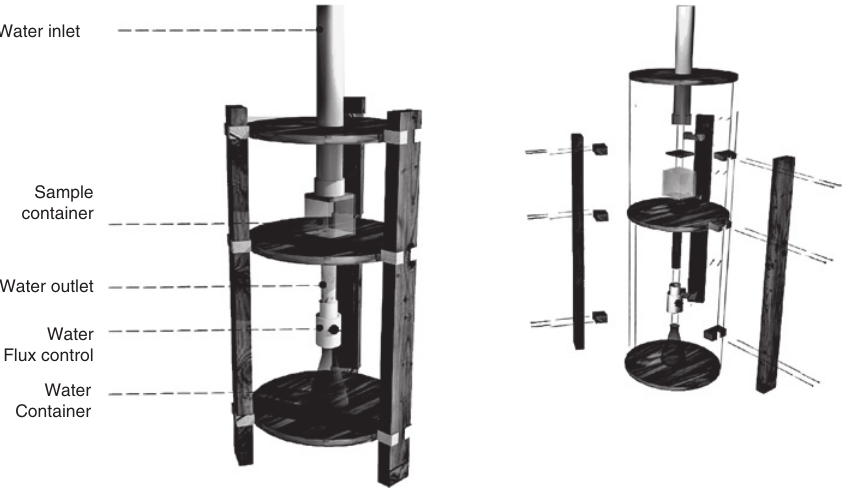
Figure 2: Schematic of the percolation